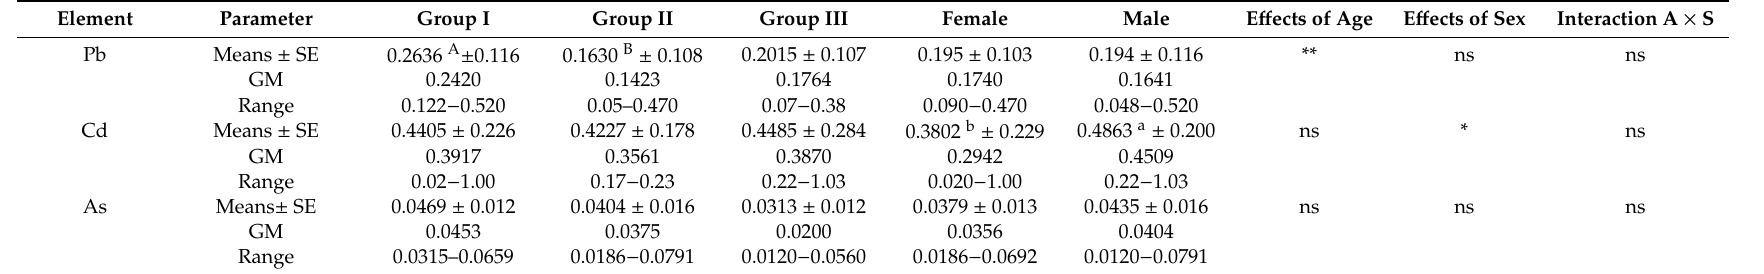
Table 2. Concentration of trace elements in wild boar liver (mg · kg − 1 wet weight).